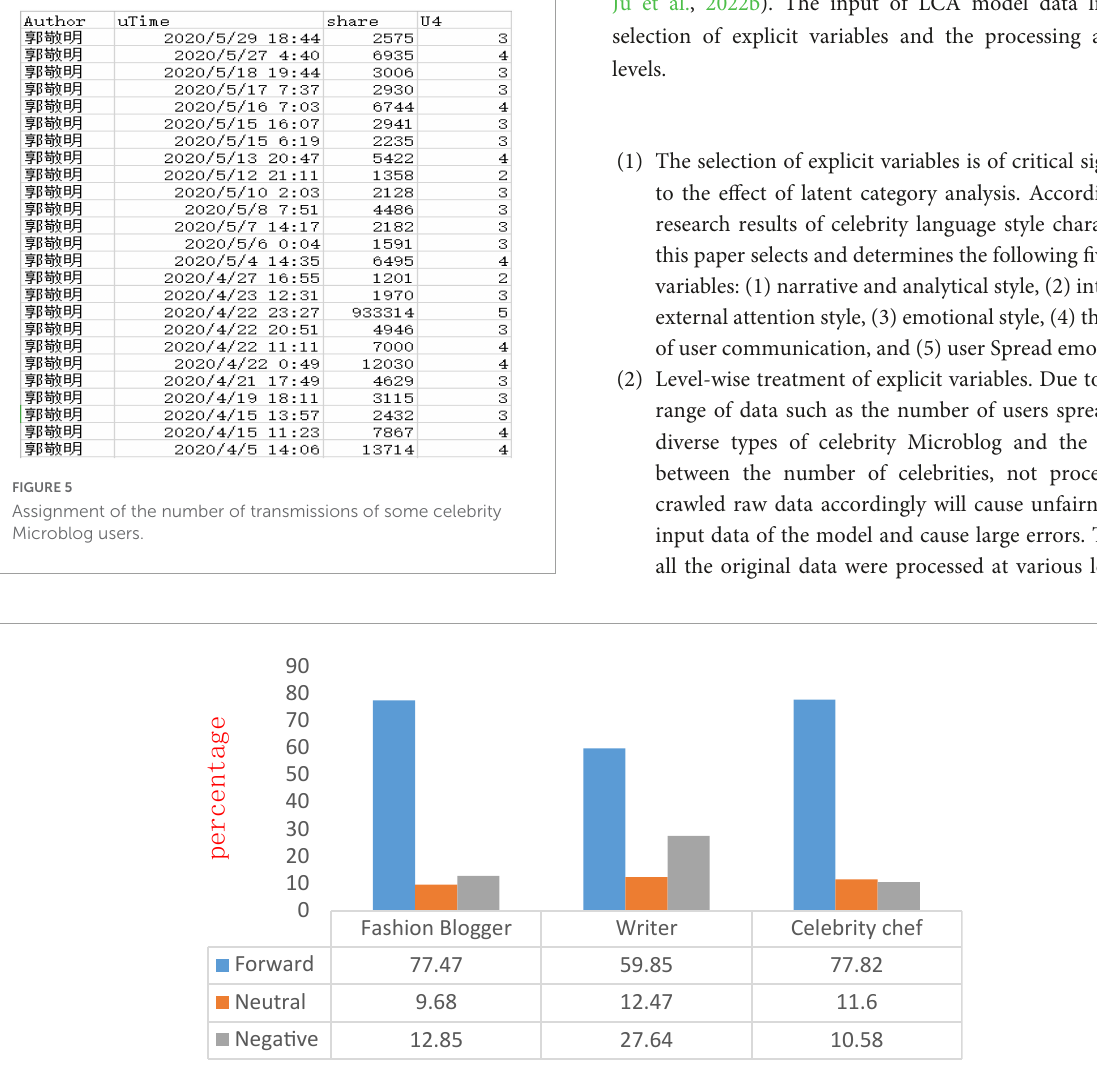
FIGURE6 Proportion of users spreading emotions on each type of celebrity